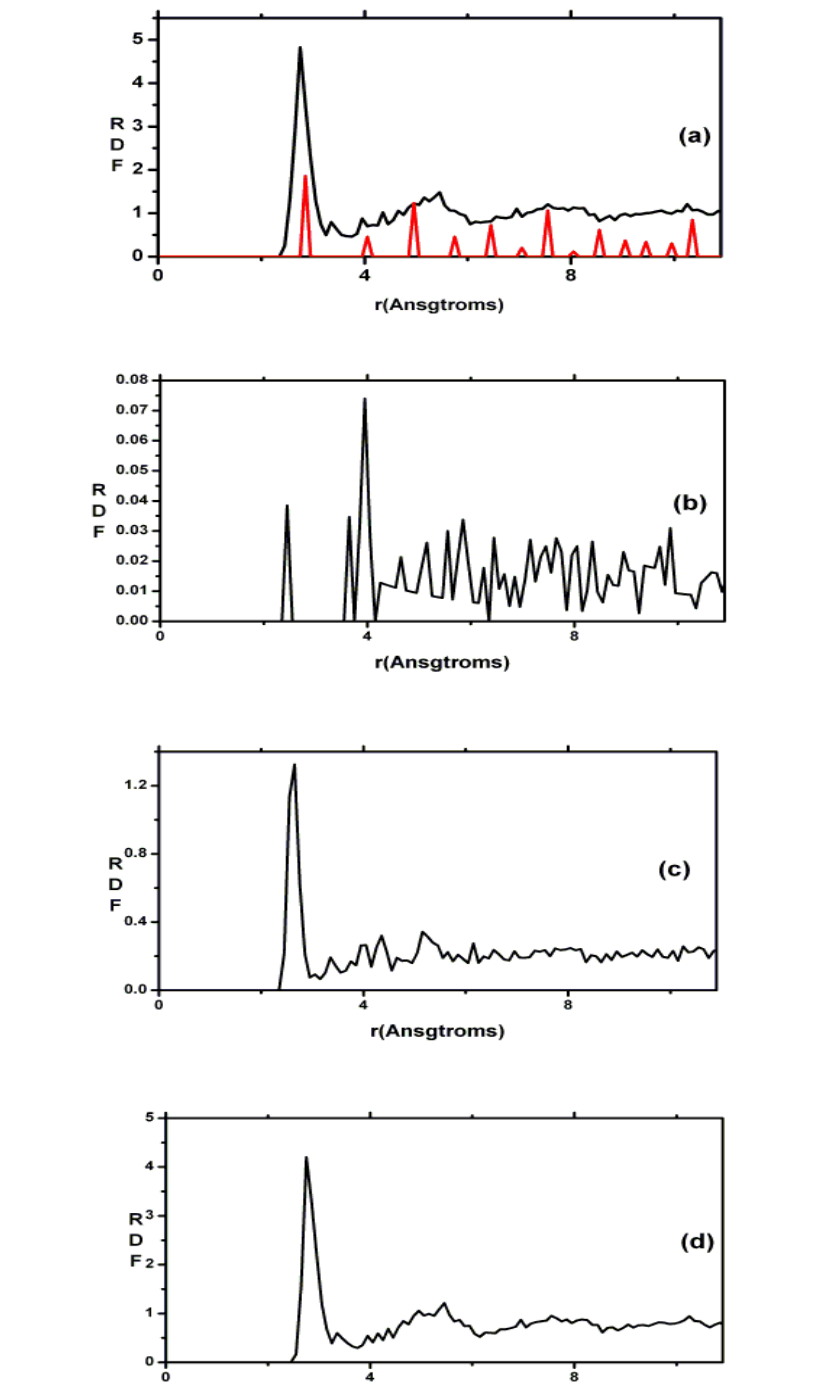
Figure 27. The system a -Al12at%Si relaxed. ( a ) Total RDF; the pRDFs are ( b ) Si–Si; ( c ) Al–Si and ( d ) Al–Al for the 15 Si and 110 Al cell. The red peaks in ( a ) are the atomic positions of the fcc